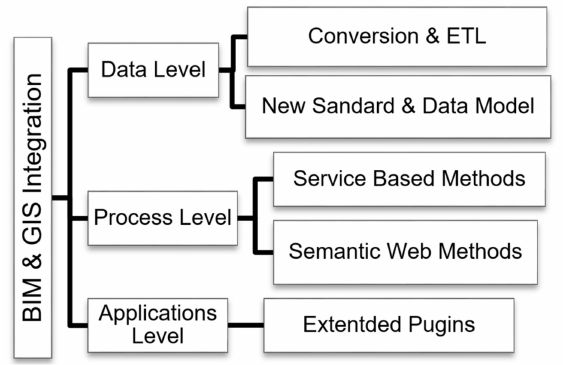
Figure 3. BIM and 3D GIS integration approaches at three levels: data, process, and